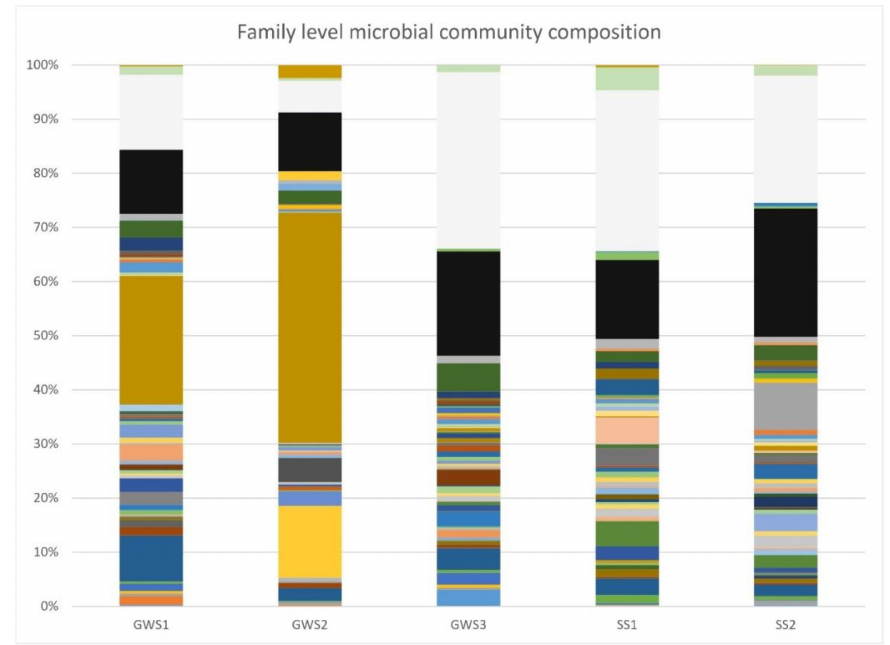
Figure 6. Family level microbial community composition in samples collected from groundwater and soil: Unclassified bacterial families are reported in light grey. Taxa with relative abundance below 0.5% are reported in black. The remaining colours indicate identified bacterial